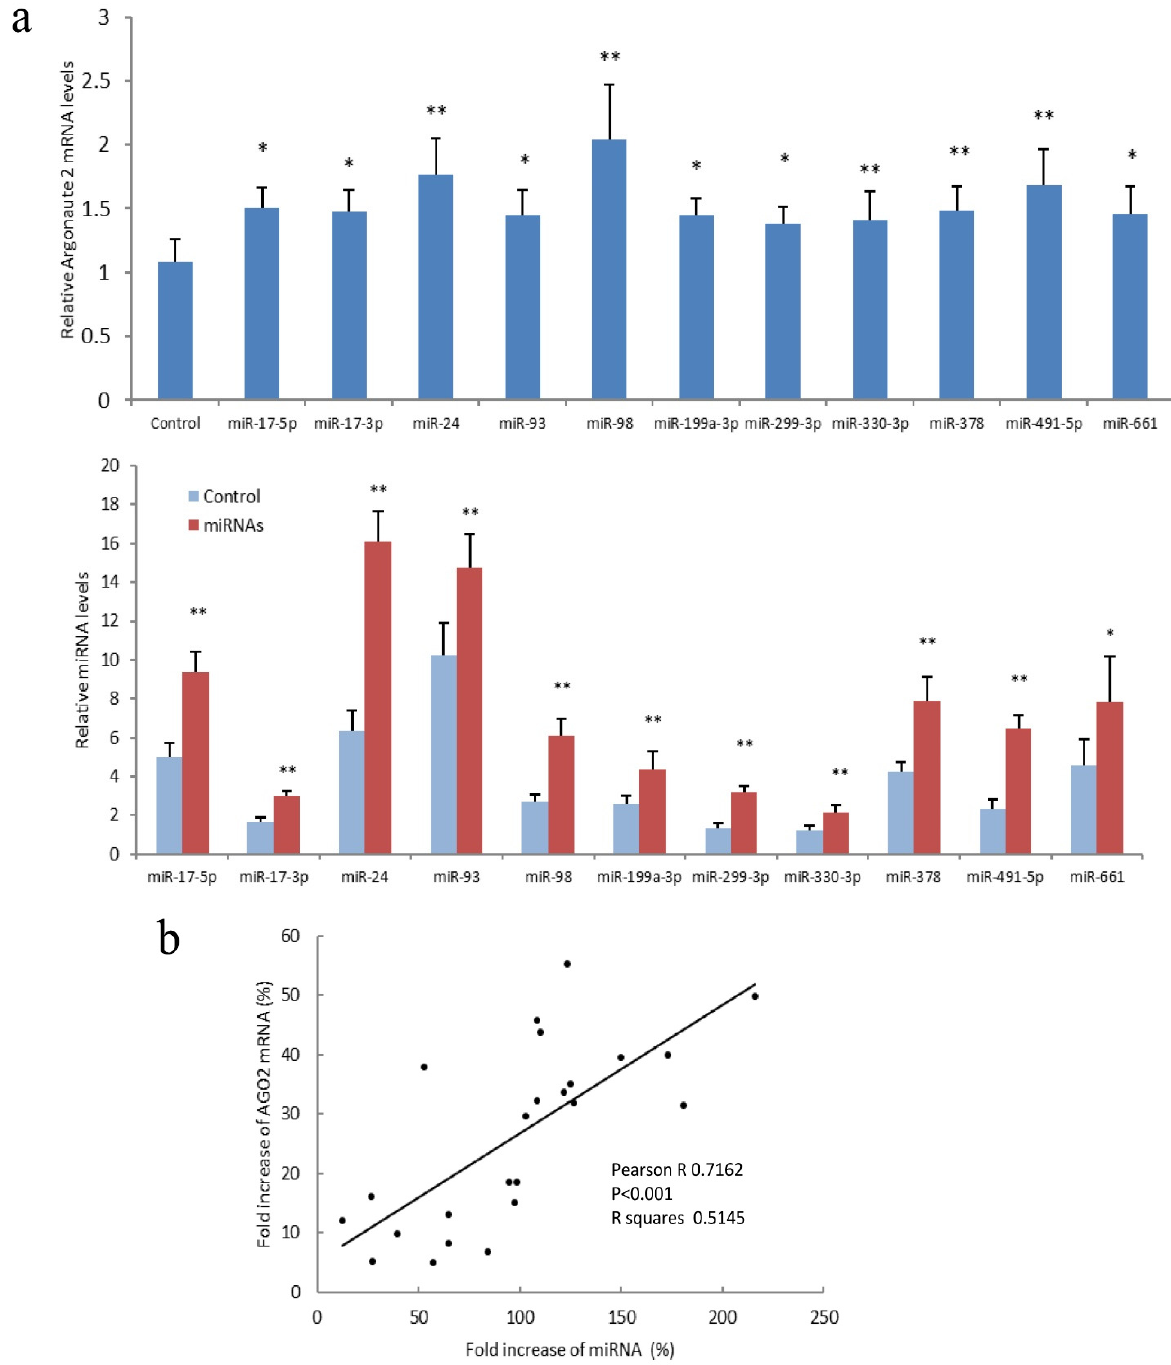
Figure 6. AGO2 expression increased with miRNA transfection. ( a ) Upper, HepG2 cells were transfected with miR-17-3p, miR-17-5p, miR-24, miR-93, miR-98, miR-199a-3p, miR-299-3p, miR-330-3p, miR-378, miR-491-5p, and miR-661. RT-PCR showed that AGO2 expression increased with the above miRNA transfection. Lower, expression of miR-17-3p, miR-17-5p, miR-24, miR-93, miR-98, miR-199a-3p, miR-299-3p, miR-330-3p, miR-378, miR-491-5p, and miR-661 expression in transfected HepG2 cells. * p < 0.05, ** p < 0.01 vs. control; Error bars, SD; n = 5. ( b ) Pearson correlation between fold increase of AGO2 mRNA and fold increase of miR-17-3p, miR-17-5p, miR-24, miR-93, miR-98, miR-199-3p, miR-299-3p, miR-330-3p, miR-378, miR-491-5p, and miR-661 in transfected HepG2 cells was analyzed by Prism 8. Fold increases in AGO2 mRNA were positively correlated with miRNA levels. Pearson R = 0.7162; p < 0.001; n = 44.